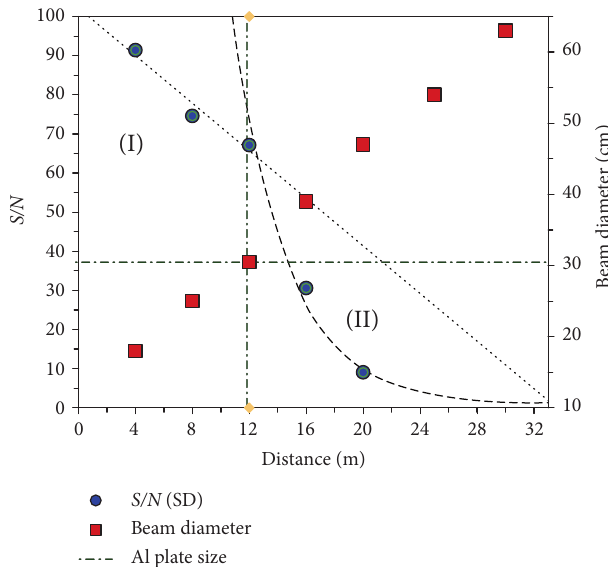
Figure 2: Signal-to-noise ratio (principal y -axis) at various distances for active mode RIRS measurements of TNT. IR beam spot size (secondary y -axis) versus range. Noise levels (as standard deviation) were measured at 830 – 870cm − 1 and peak heights were measured for TNT signal at 790 cm − 1